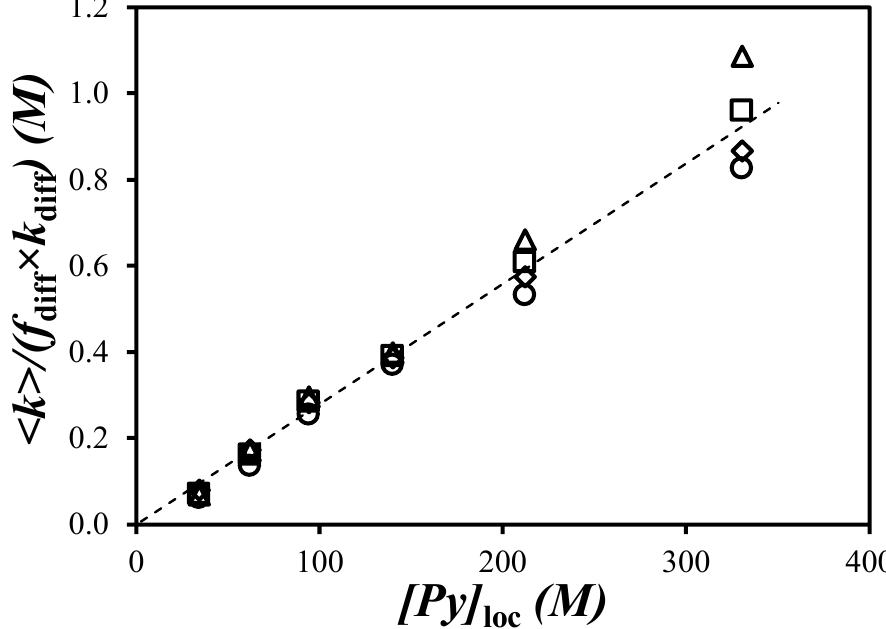
Figure 6. Plot of < k >/( f diff × k diff ) as a function of [ Py ] loc for the Py x -G( N ) dendrons where the < k > values obtained for the dendrimers in a given solvent are divided by f diff to account for possible aggregation of the pyrenyl labels and k diff obtained from the MFA of the PyBE fluorescence decays in the same solvent to account for the p / η term in Equations (8)–(9); ( ) toluene, ( ) THF [29], ( ) DMF, and ( ) DMSO.